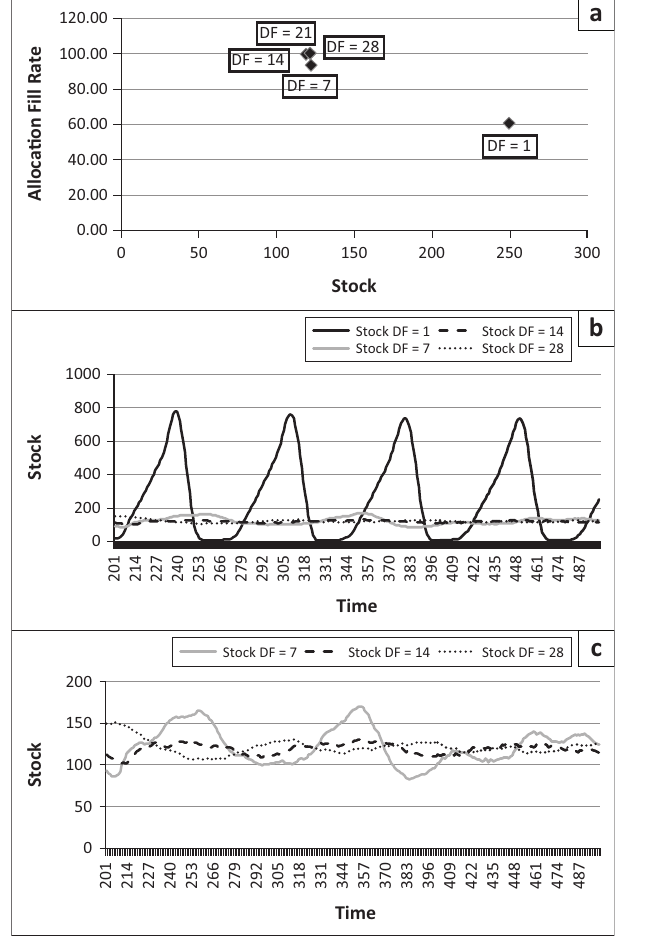
FIGURE 4: Impact of the damping factor on a past model local supplier supply chain where damping factor is (a and b) equal to 1 and (c) when damping factor equal to 1 is